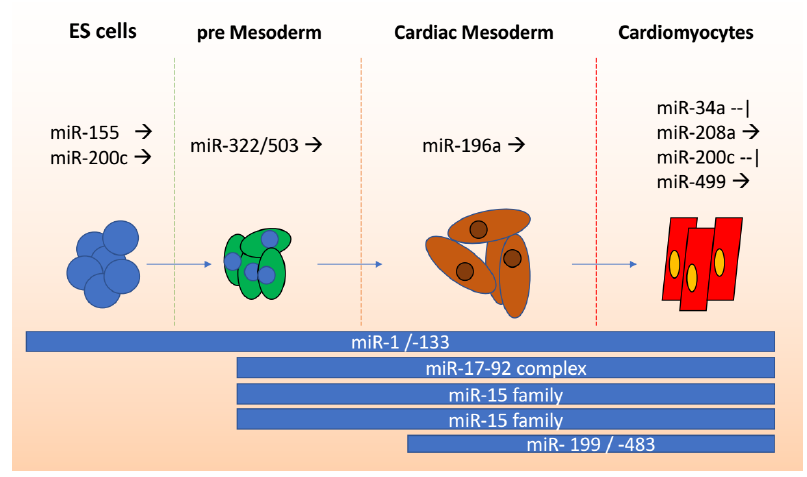
Figure 2. Embryonic Stem cells to cardiomyocytes. Left to right, the tight regulation of miRNAs during ES cell differentiation (blue) to cardiomyocytes (red) including pre- (green) and mesoderm stages (brown). The top shows important miRNA activators (black arrows) and repressors (black stops) at specific stages. The bottom part (in blue lines) shows continuous miRNA activation during prolonged stages.